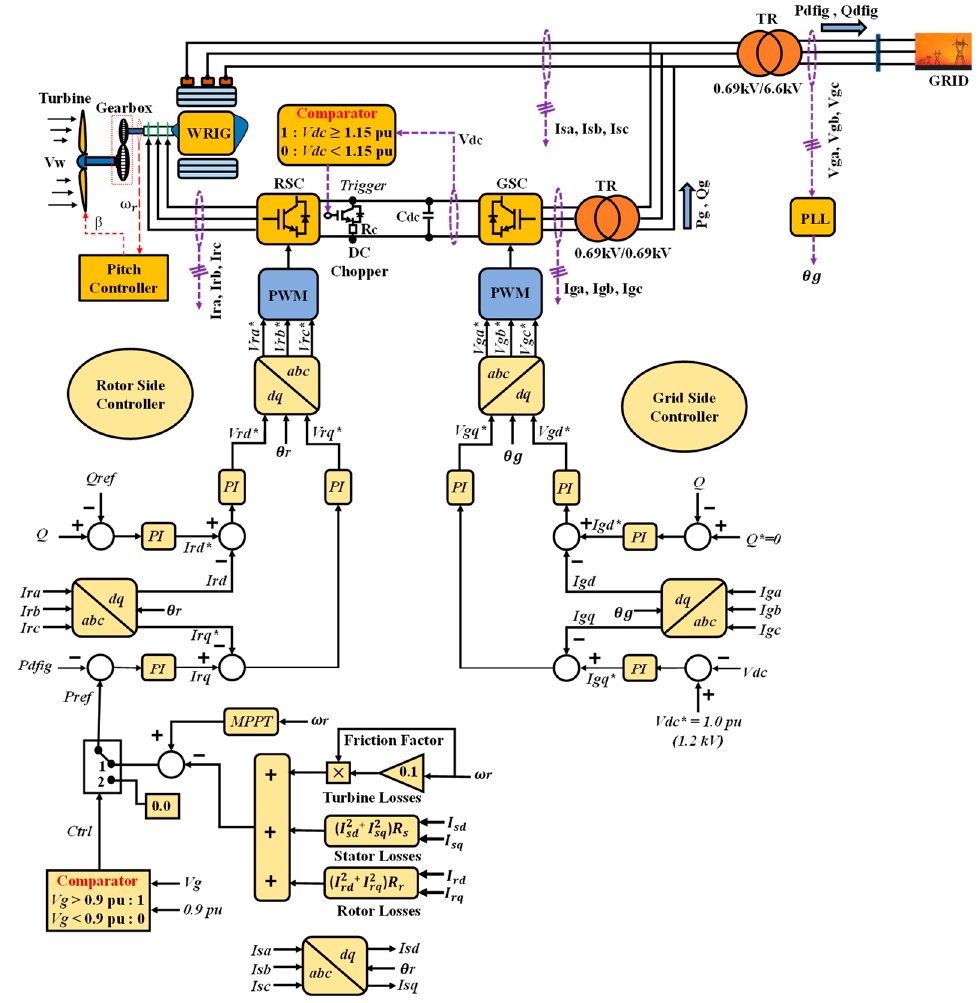
Figure 7. DFIG system with cascaded control strategies.